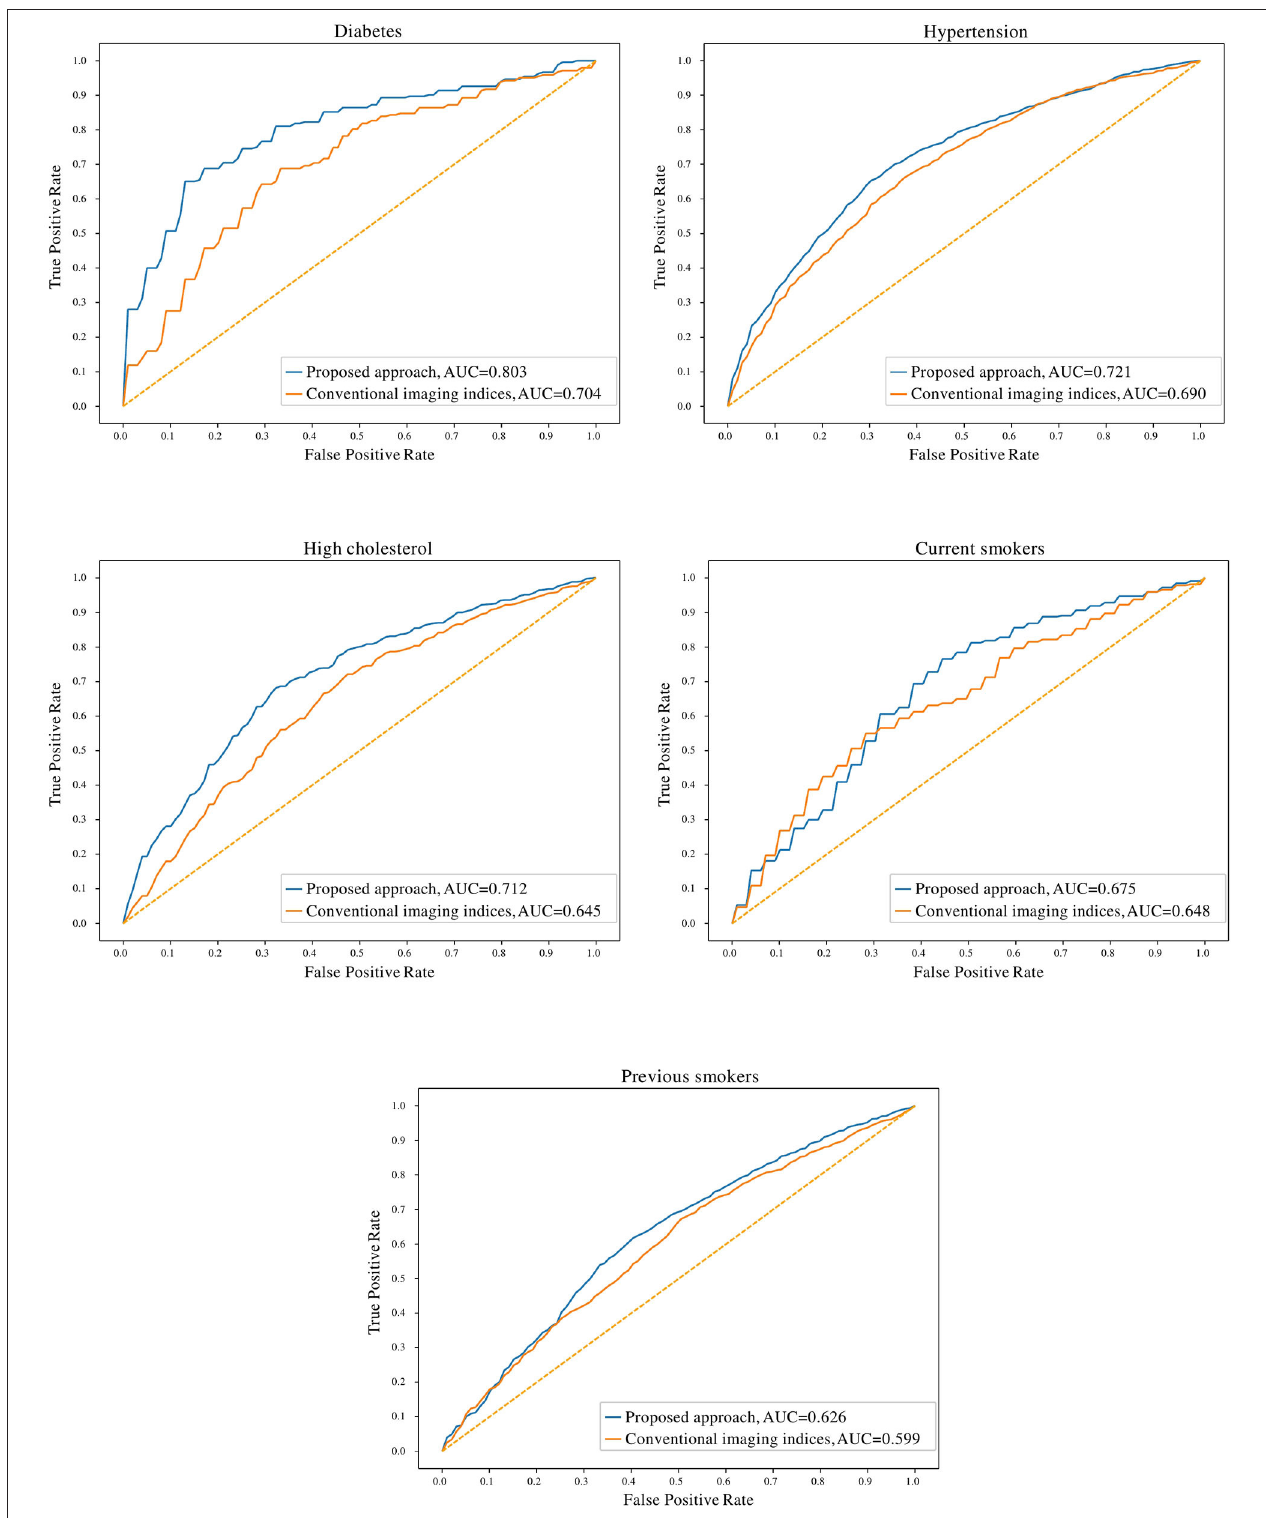
FIGURE 3 | Receiver operating characteristic curves for radiomics and conventional CMR indices models for the cardiovascular risk factor subgroups. AUC: area under the curve.